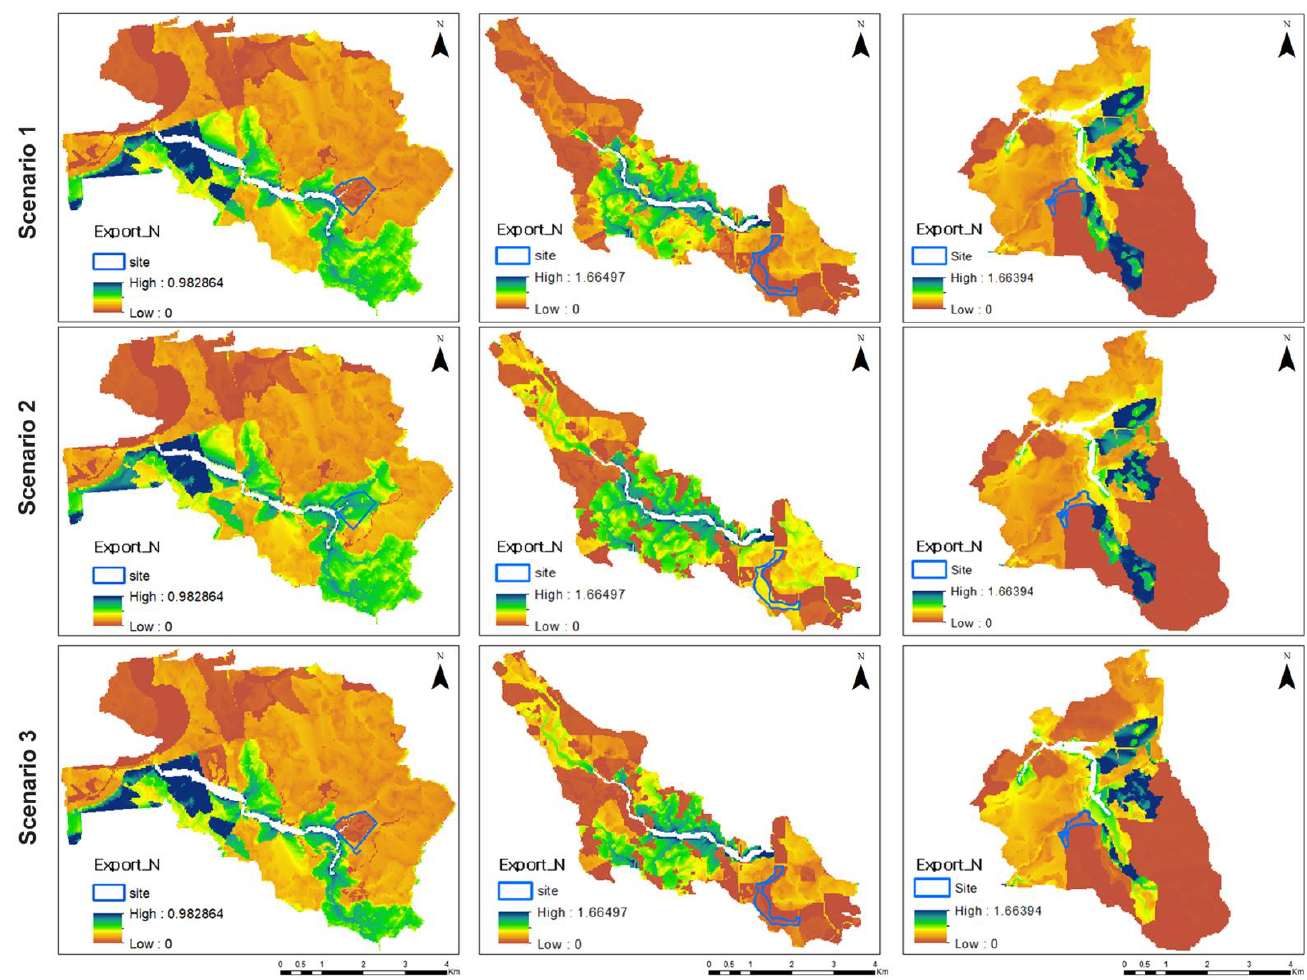
Figure 4. Spatial distribution of the nitrogen load of each study area.